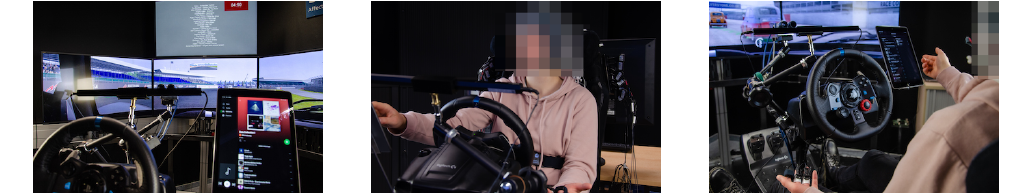
Figure 2. ( Left )-to-( Right ): Overview of the test environment with a depicted multi-monitor setup, subject in driving seat and acquisition setup; View from the subject’s right shoulder perspective; View over the shoulder, with the steering wheel, camera, eye tracker and tablet cockpit; Frontal view of the subject fully connected to all bio-signals.